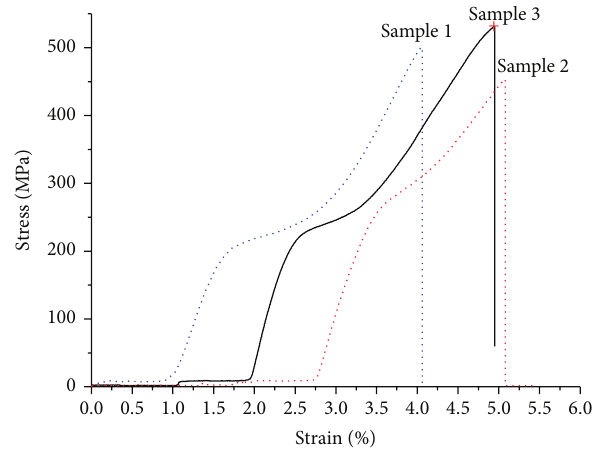
Figure 10: Stress-strain curves of the welded material for different heat input.